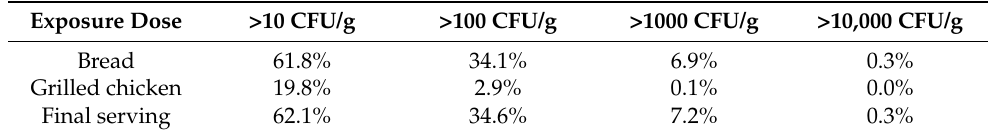
Table 3. Probability of the consumer being exposed to specific ESBL-/AmpC-producing E. coli concentrations through consumption of a portion of bread, grilled chicken and the final serving.